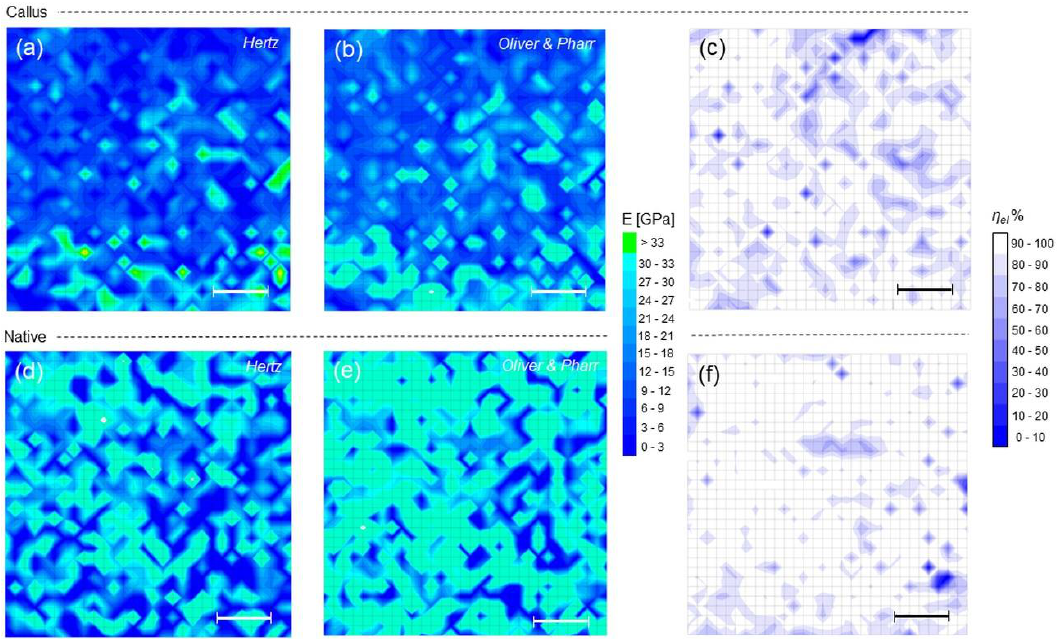
Figure 4. ( a , b ) Young’s modulus maps calculated according to Hertz and Oliver–Pharr models, and ( c ) ηel map for callus; ( d – f ) the same as ( a – c ) for native bone. Table 1. h max , η el and Young’s moduli extracted from the maps of Figures 3 and 4. The values span the 25th to the 75th percentile.